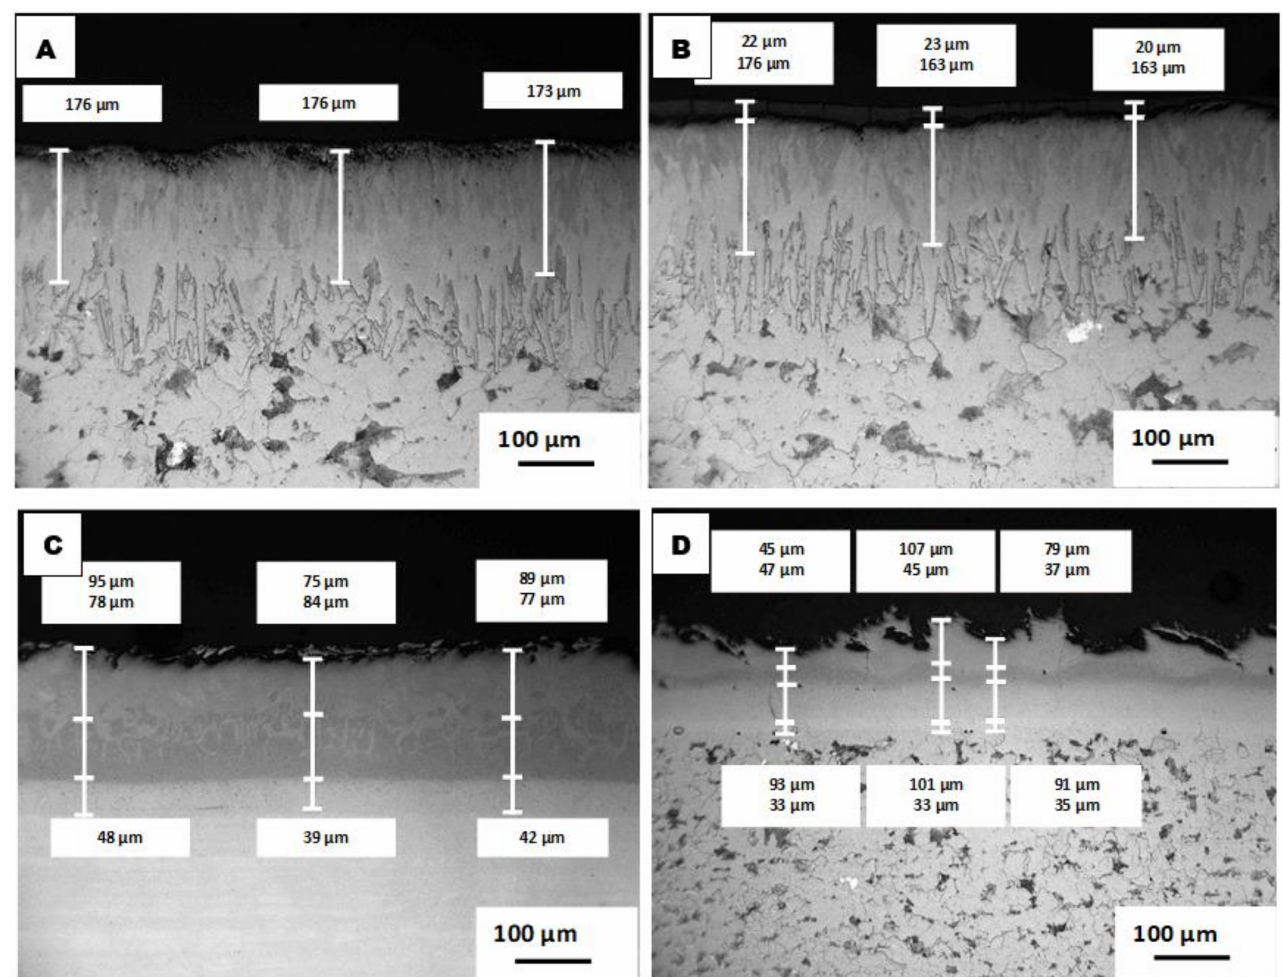
Figure 2. Microstructure of the coatings (LOM, cross-sections) before testing: Top layer—( A ) boronized carbon steel (B) (left); boronized carbon steel with ( B) TiO 2 top layer (BT) (right). Bottom layer—( C ) aluminized stainless steel 316L (6A) (left); ( D ) aluminized carbon steel (A)